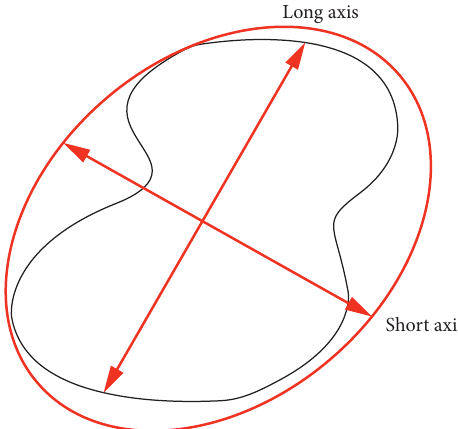
Figure 5: Schematic diagram of pore